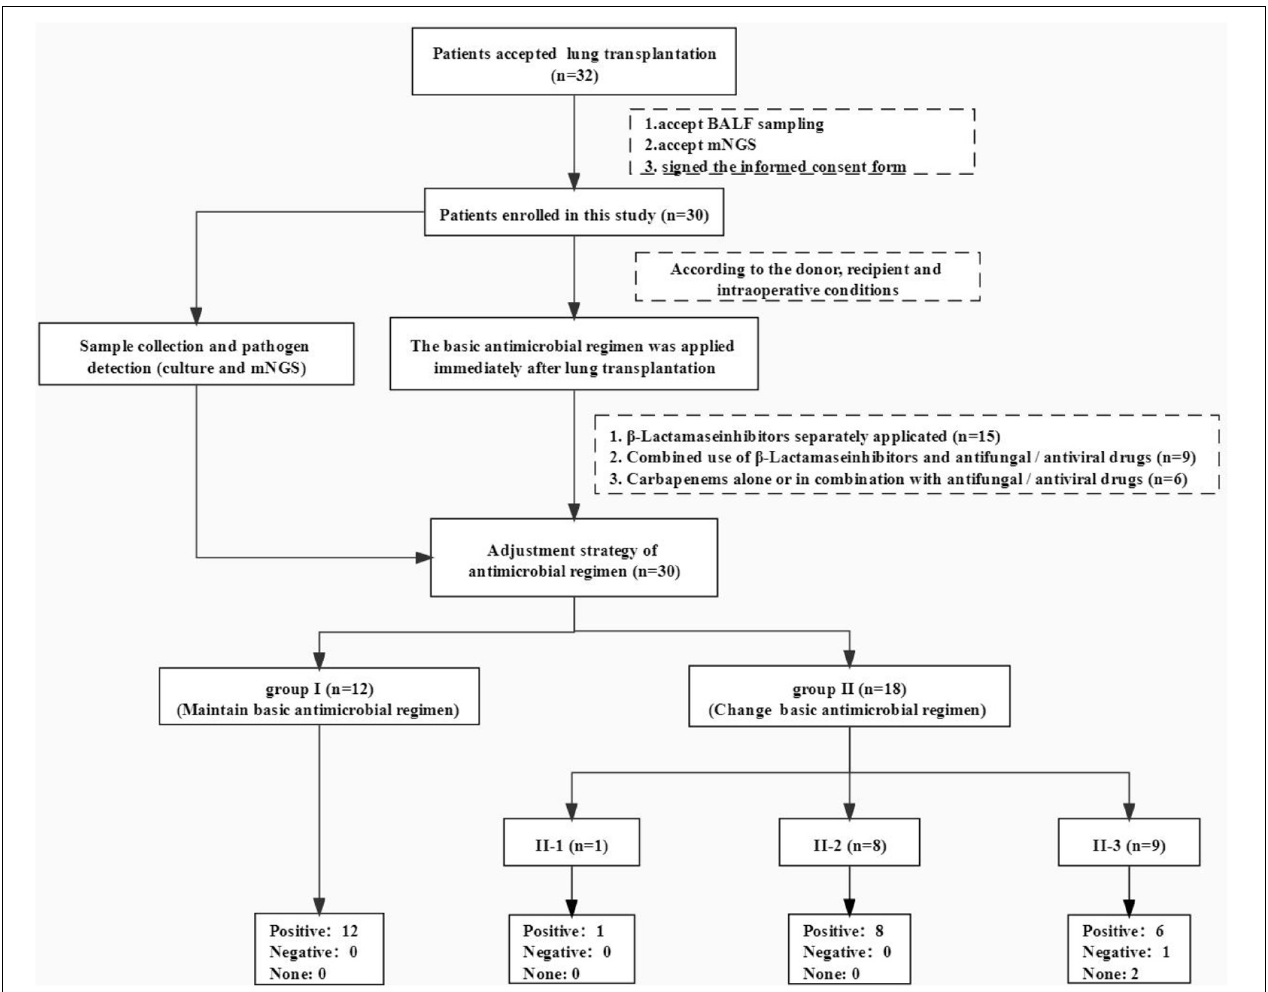
FIGURE 1 | Flowchart of this study. We completed 32 lung transplants in total, 30 cases of which were included in this study, whose multiple clinical samples were sent to mNGS test and traditional culture at the same time. We prescribed those patients some basic antibiotic regimens (relatively narrow-spectrum antibiotics) immediately then made adjustments according to the clinical condition, pathogen test results (mNGS and pathogen culture of different samples), and experts’ opinions. At least two transplant management experts evaluated the effectiveness of our antibiotic adjustment